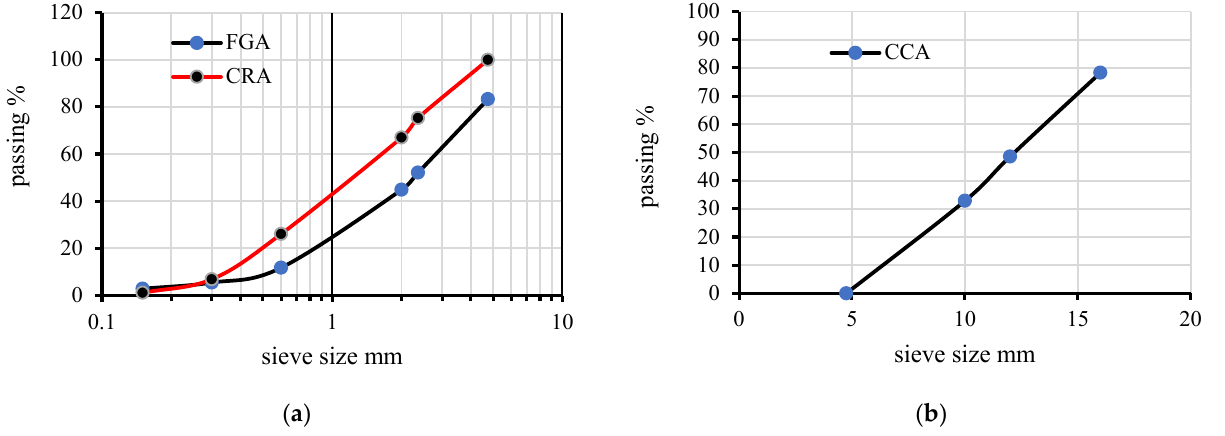
Figure 6. Sieve analysis for the recycled aggregates. ( a ) Fine aggregate FGA and CRA; ( b ) Coarse aggregate CCA. Table 2. Proportion of the concrete mixtures (kg/m 3 ).